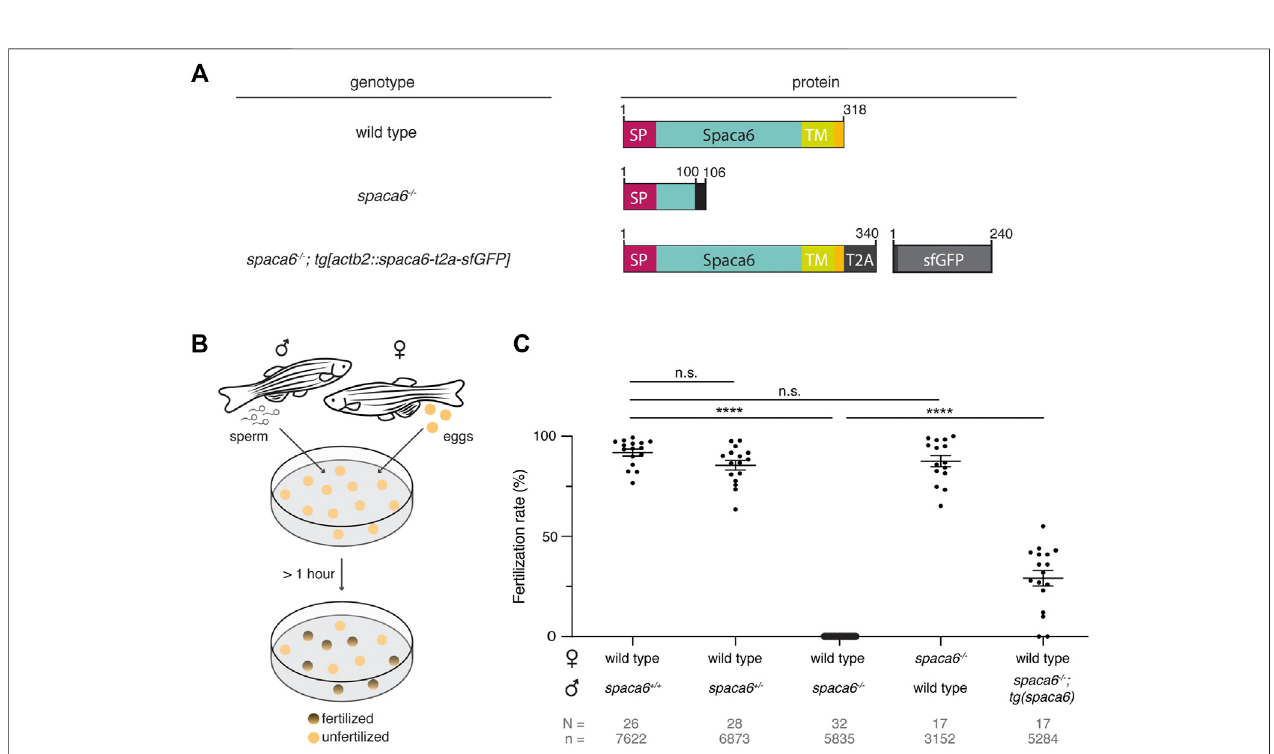
FIGURE2| Zebra fi shSpaca6isessentialformalefertility. (A) .DiagramsofSpaca6proteinsmadeinwild-type, spaca6 − / − andrescue[ spaca6 − / − ; tg ( actb2:spaca6- t2a-GFP )] zebra fi sh lines. An 86-nt deletion in the spaca6 − / − line leads to a retained sequence from intron two and a premature stop-codon, resulting in a dysfunctional truncated protein (translated part of the intron is shown in black). In the rescue line, a SGGSG spacer and a part of the viral T2A protein result in a C-terminal 23-aa addition. The amino acid position is given above the scheme. Signal peptide (SP), red; Extracellular domain, blue; Transmembrane domain (TM), green; Cytoplasmic domain, yellow. (B) . Scheme of a mating assay performed to quantify fertilization rates. Fish and gametes are not drawn to scale. (C) . Quanti fi cation of fertilization rates. Fertilization rateswere calculated by counting the number of embryos that developed beyond the one-cell stage. ****, p < 0.0001(Mann-Whitney test); n.s, not signi fi cant; error bars, standard deviation (SD); N (cid:1) number of crosses; n (cid:1) number of embryos.